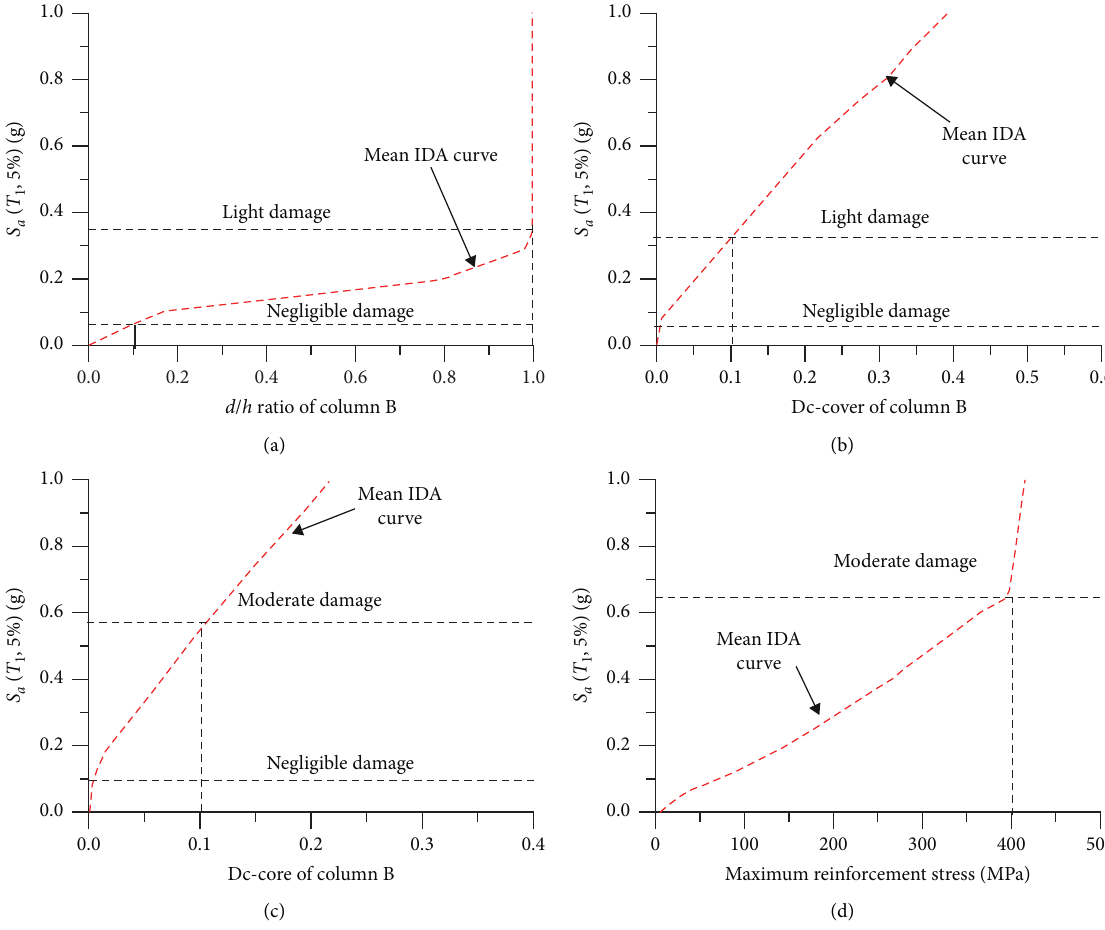
Figure 13: Mean IDA curves of EDPs. (a) d / h . (b) D